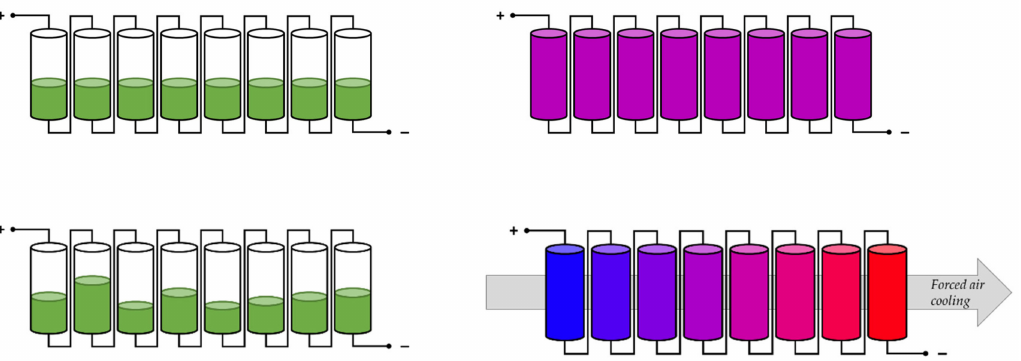
Figure 2. Schematic representation of cell-to-cell differences on SOC ( left ) and temperature ( right ), showing balanced ( top ) and imbalanced modules ( bottom ) of 8 cells in series. As suggested on the bottom-left schematic, non-uniform cooling can lead to temperature imbalances, but other reasons are